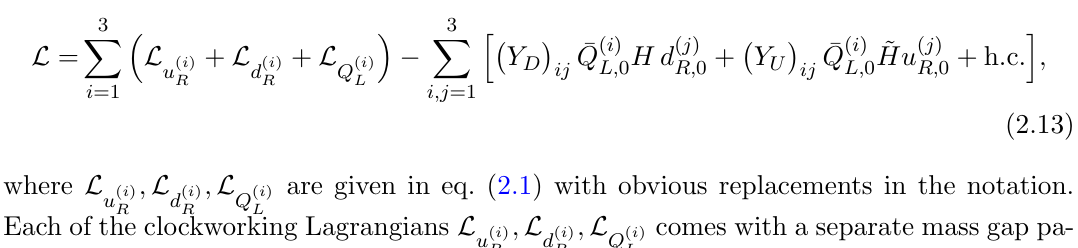
Figure 3 . The clockwork chains of vector-like fermions for each of the (cid:13)avors meet at the central node, the only one that contains the Higgs. The (cid:12)eld content of each node is denoted in blue. the right-handed down quarks, d ( i ) and the left-handed doublets, Q ( i ) are supplemented by R L their own vector-like chains. In general, the chains are of di(cid:11)erent lengths, N . ( i ) The Lagrangian for three generations is thus given